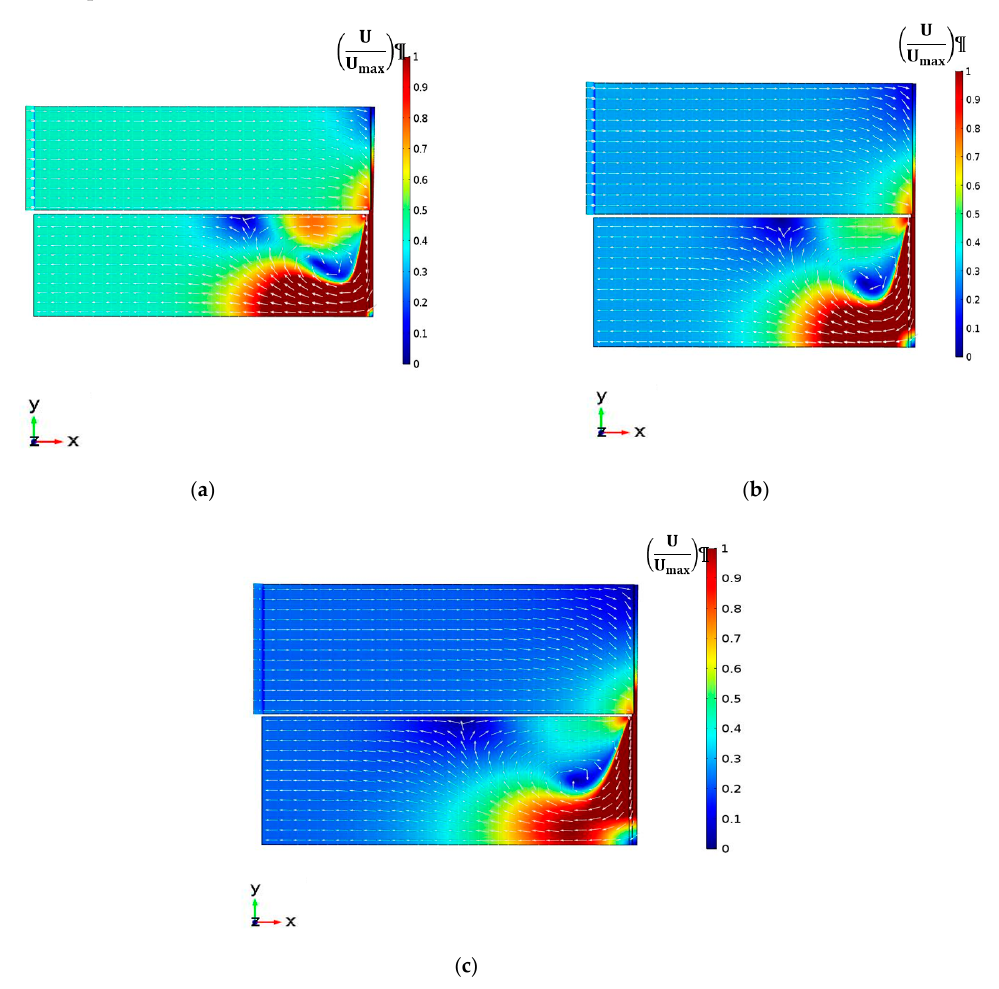
Figure 7. Velocity vector plots at a constant mass flow rate of 2.4 kg/s, slope angle of 1°, and various channel width/channel depth ratios: ( a ) channel width/channel depth = 180, ( b ) channel width/channel depth = 260, and ( c ) channel width/channel depth = 340.